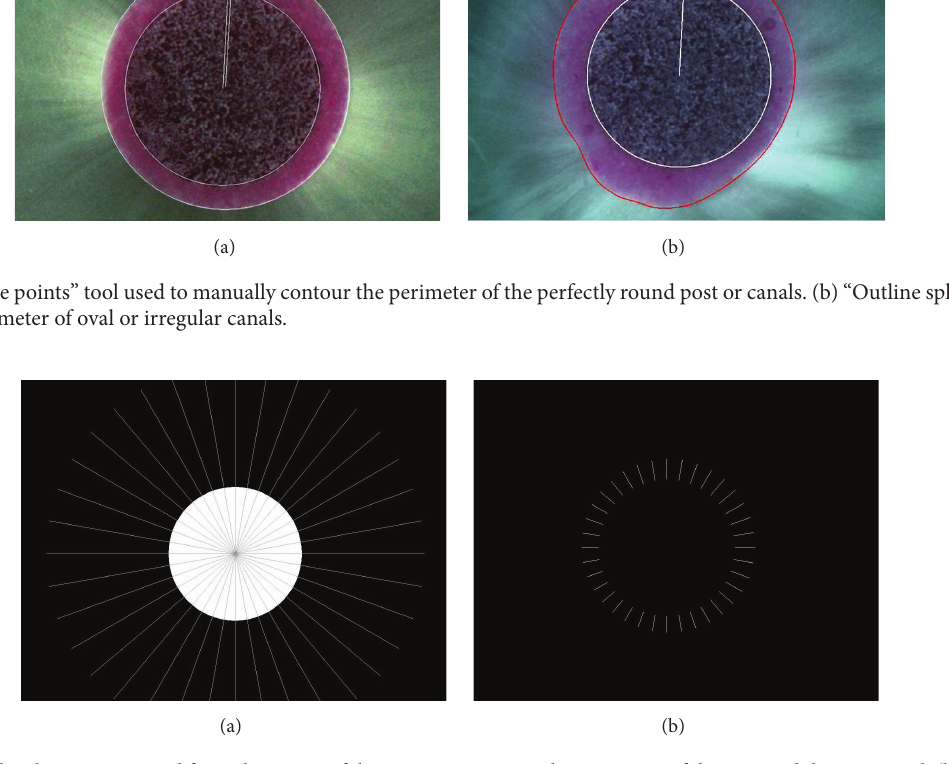
Figure 2: (a) 36 radius lines were traced from the center of the post, intercepting the perimeter of the post and the root canal. (b) Intersection of the radius lines with the resin cement